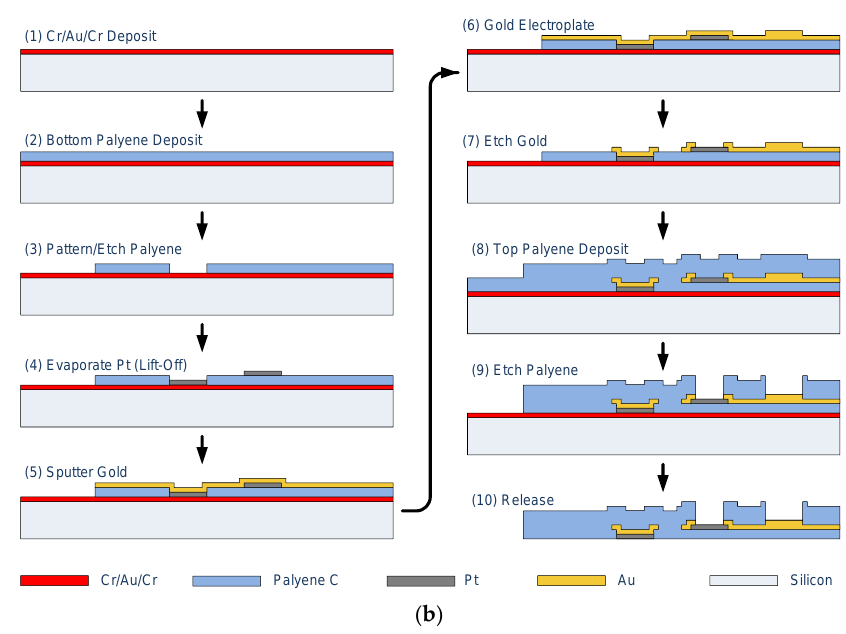
Figure 12. A flexible microelectrode array: ( a ) configuration ( b ) fabrication flow chart.